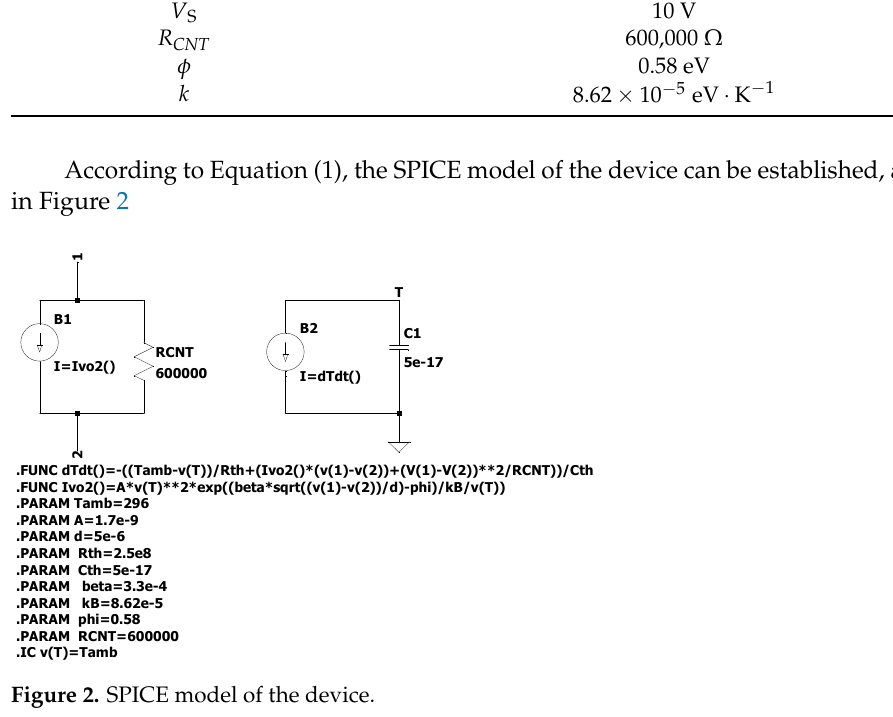
Figure 2. SPICE model of the device. The quasi-static volt-ampere characteristics of the device can be obtained by using the SPICE model, as shown in Figure 3.